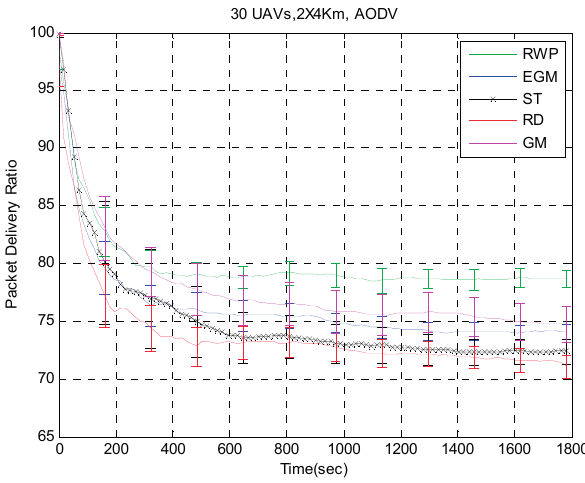
Figure 9. The packet delivery ration (PDR) of AODV under various mobility models.